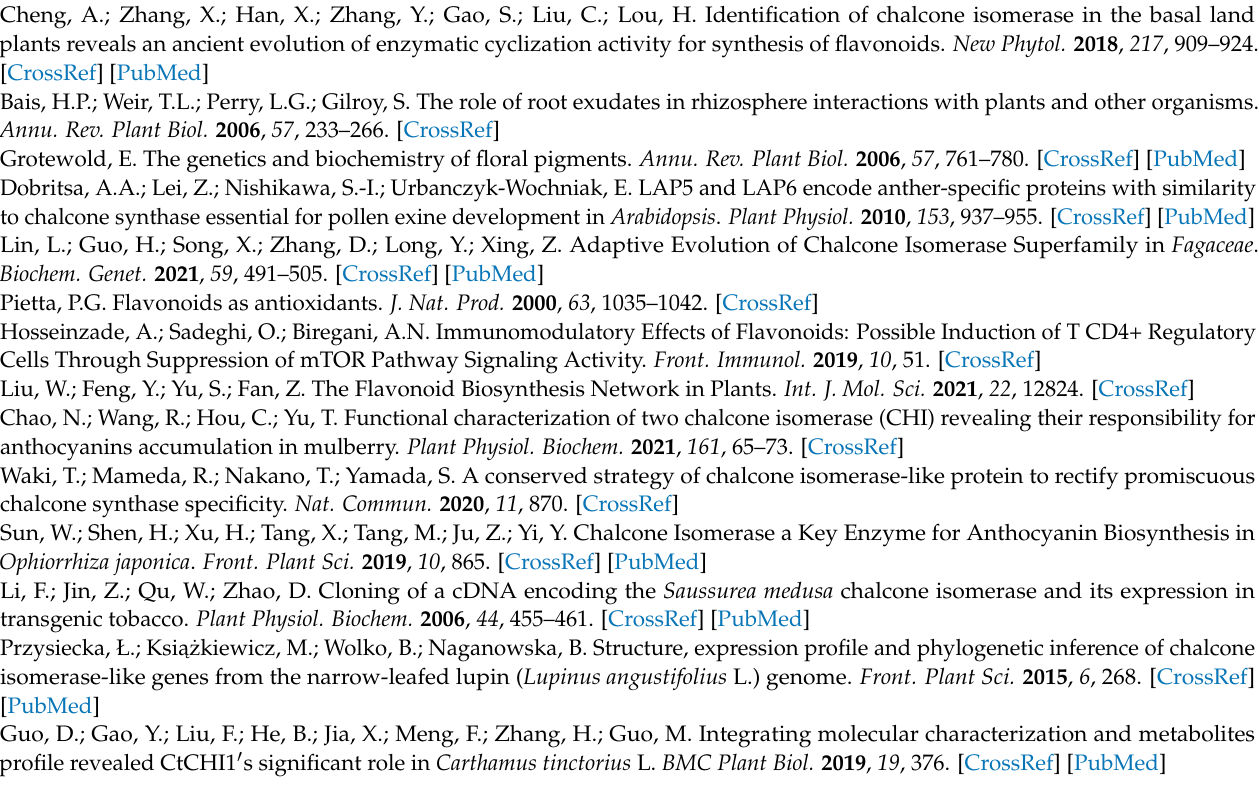
Table S6: Sequences of primers used for dual-luciferase assays; Supplementary Table S7: Sequences of primers used for Y1H assays; Supplementary Table S8: Prediction results of cis-acting elements in the promoter sequences of CnCHI4